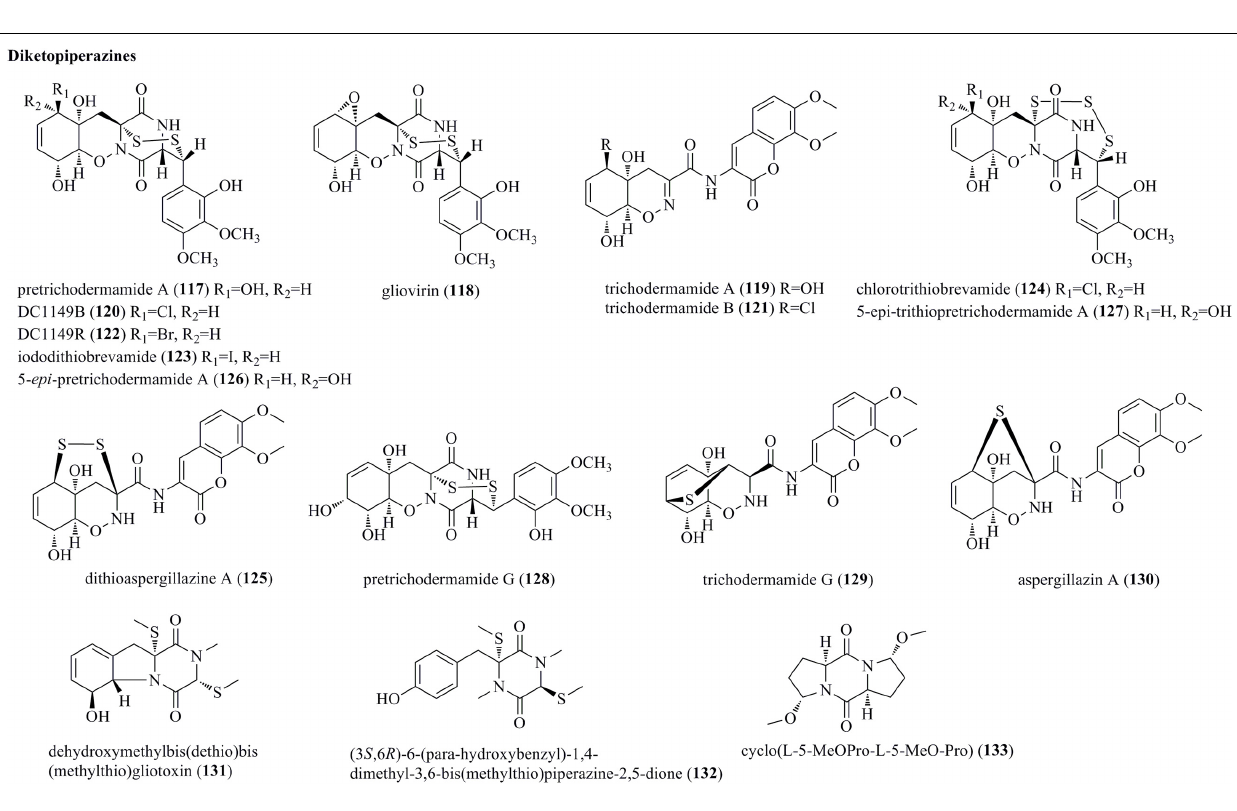
FIGURE 6 | Diketopiperazines produced by Trichoderma species ( 117–133 ).